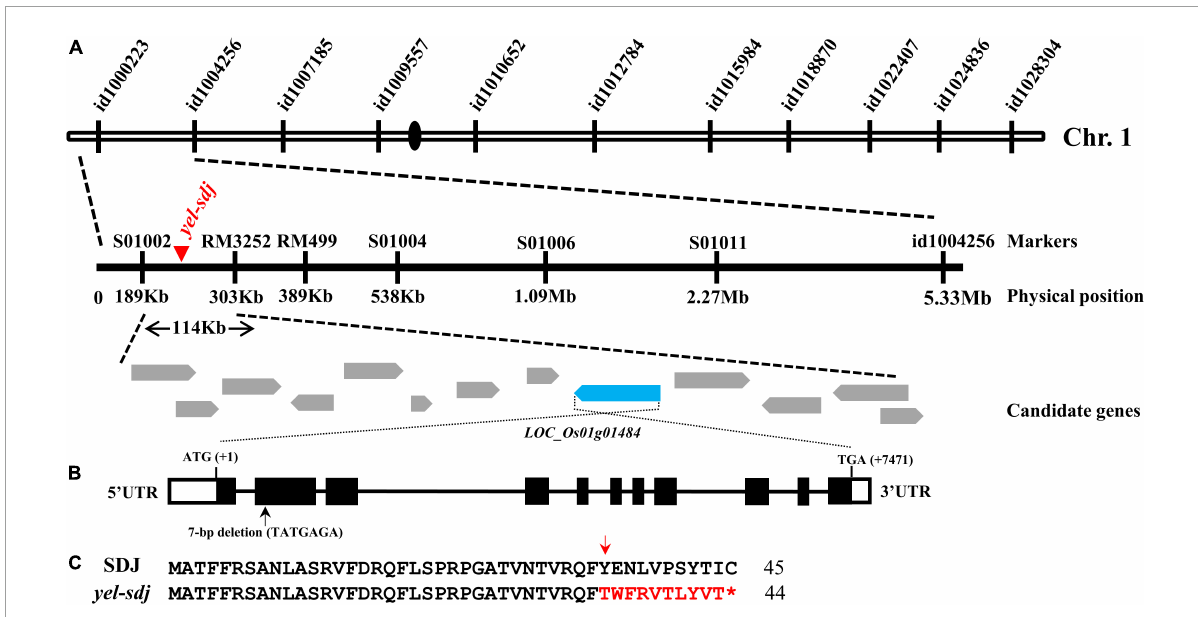
FIGURE2 Map-based cloning of the gene responsible for the yel-sdj mutant phenotype. (A) Schematic showing the physical position of the causal locus on rice chromosome 1, as identified by map-based cloning. (B) Gene structure of OsDET1 . Black lines, white solid boxes, and black solid boxes indicate introns, untranslated regions, and exons, respectively. The 7 bp deletion is indicated with a black arrow. ATG and TGA indicate the initiation and termination codons, respectively. (C) Comparison of the predicted amino acid sequence of the mutated region of gene between the WT (SDJ) and yel - sdj mutant. The 7 bp deletion resulted in a frameshift (red arrow) and premature stop (red asterisk) in yel - sdj . Amino acids in the frameshift region are indicated in red.